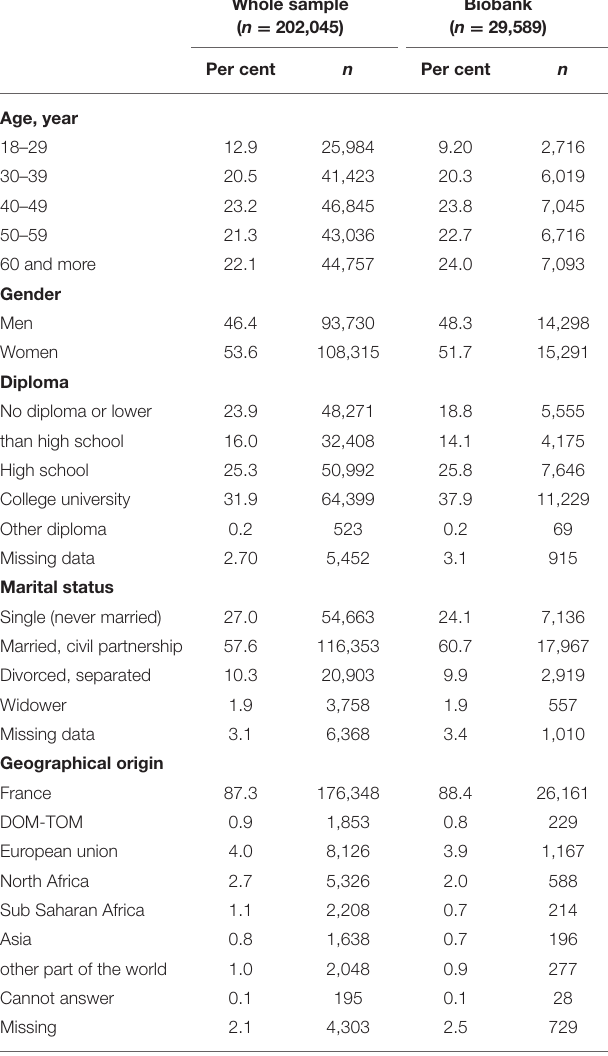
TABLE 2 | Main sociodemographic characteristics of the whole CONSTANCES sample and of the biobank participants *